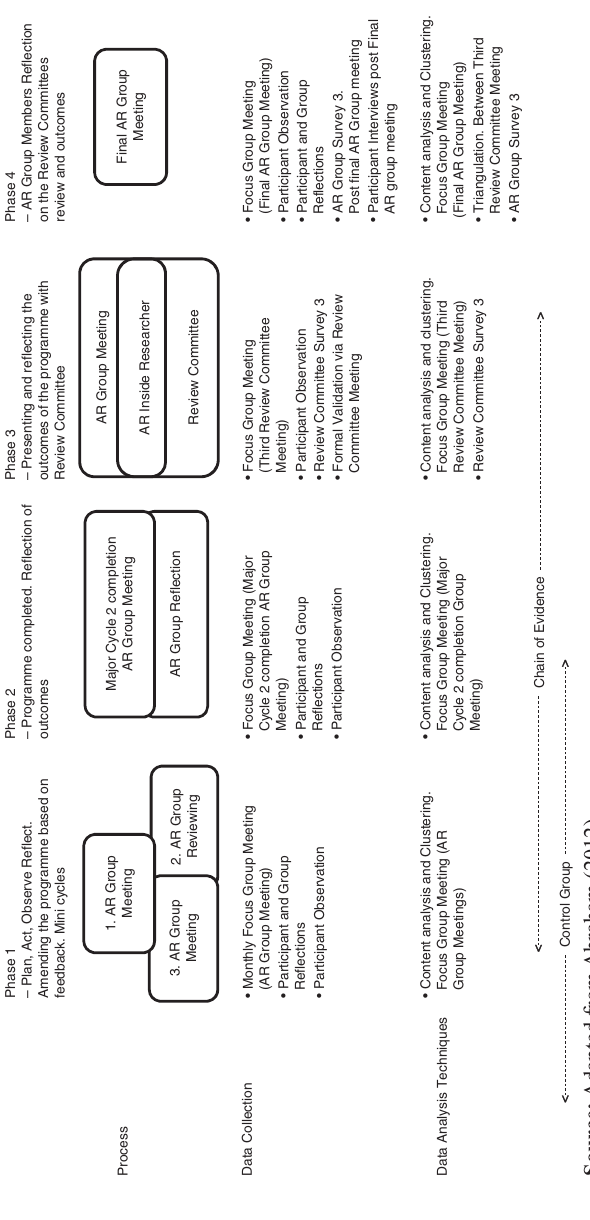
Figure 3. Major cycle 2: five months in